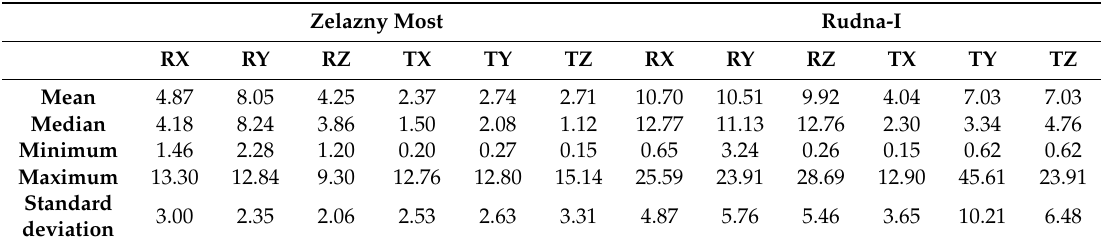
Table 2. Descriptive statistics of dominant frequency distribution at both measuring posts.